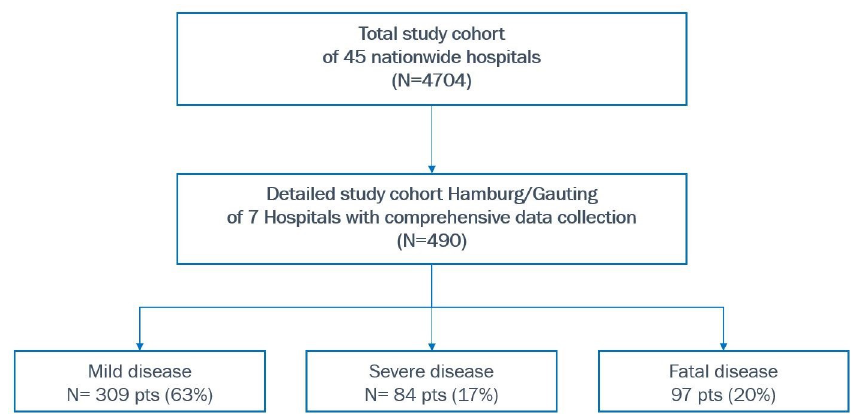
Fig 2. Flowchart of the trial showing the entire study population and the cohort Hamburg/Gauting with the primary endpoint mortality and severity of disease (mild, severe and fatal course).